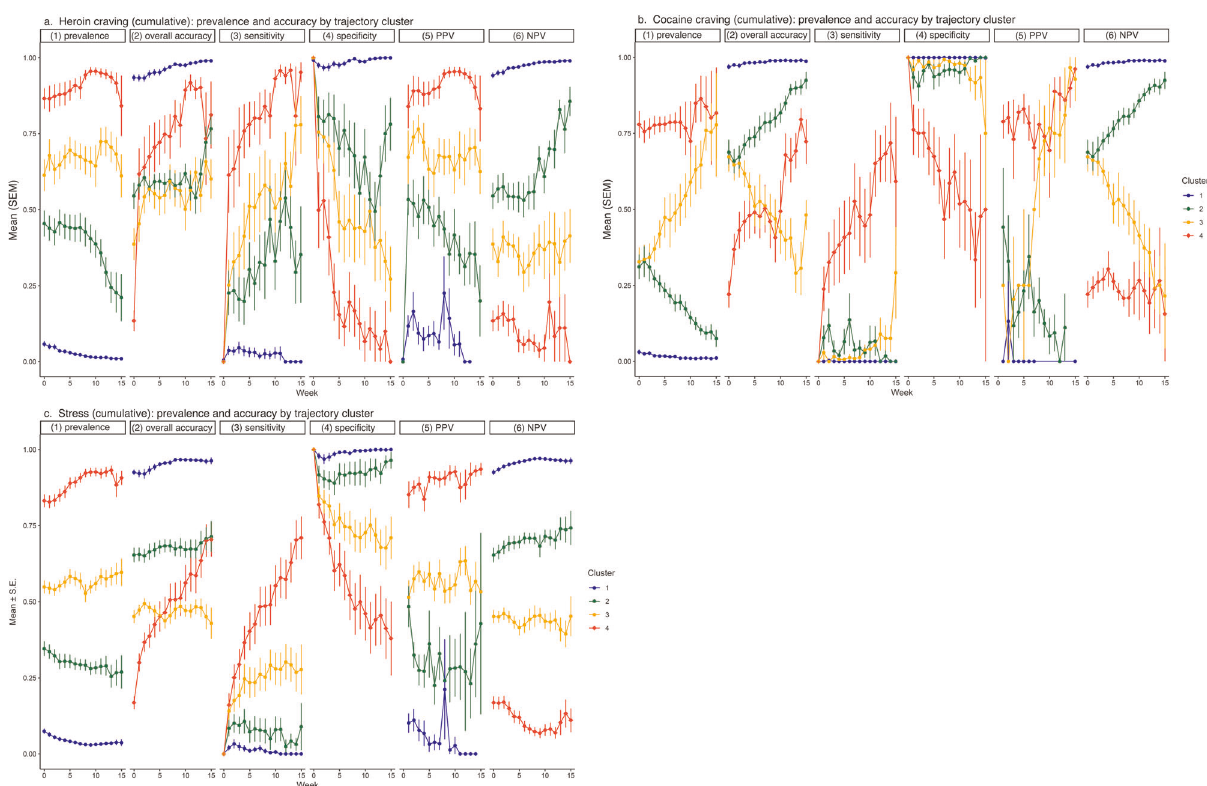
Fig. 8 Prediction accuracy (and prediction-target prevalence) per person per week, by cluster. a Heroin craving, b cocaine craving, and c stress. Details as in Fig. 2. For measures of accuracy, the main effect of cluster is always signi fi cant, and, in Tukey pairwise comparisons, nearly all pairs of clusters differ from each